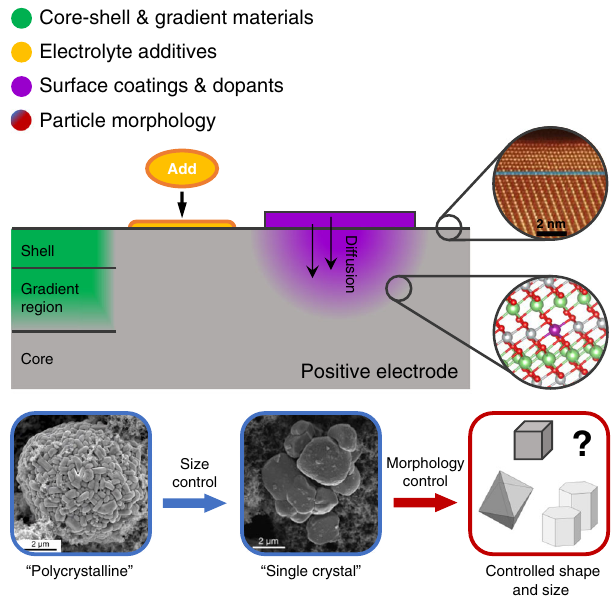
Fig. 1 Potential approaches for improving lifetime of LiMO 2 positive electrodes. Core-shell and gradient materials utilise more stable compositions (often lower Ni-content) near the electrode surface to minimise electrode-electrolyte reactivity and a nickel-rich core stoichiometry to increase energy density. Electrolyte additives are compounds added to the electrolyte solution on the order of a few weight per cent to improve cell lifetime and safety, for example by reacting with the electrode surface to form a protective ‘ barrier ’ layer. Surface coatings (applied via a variety of methods) on the electrode material can improve cycling stability and lifetime by scavenging corrosive HF, physical blockage of electrolyte components from reaching the electrode surface, slowing RSL growth by blocking oxygen loss from the active material, and via other chemical reactions with the electrolyte components. Heat treatments of surface-coated materials can be used to prepare surface-doped materials with improved chemical stability and that inhibit the growth of surface rock- salt layers. One trend in particle morphology research is to increase primary particle sizes (i.e., transition from polycrystalline to ‘ single crystal ’ materials), while future prospects include the synthesis of fi nely tuned particle shapes and sizes. (TEM of RSL adapted from Lin et al. 14